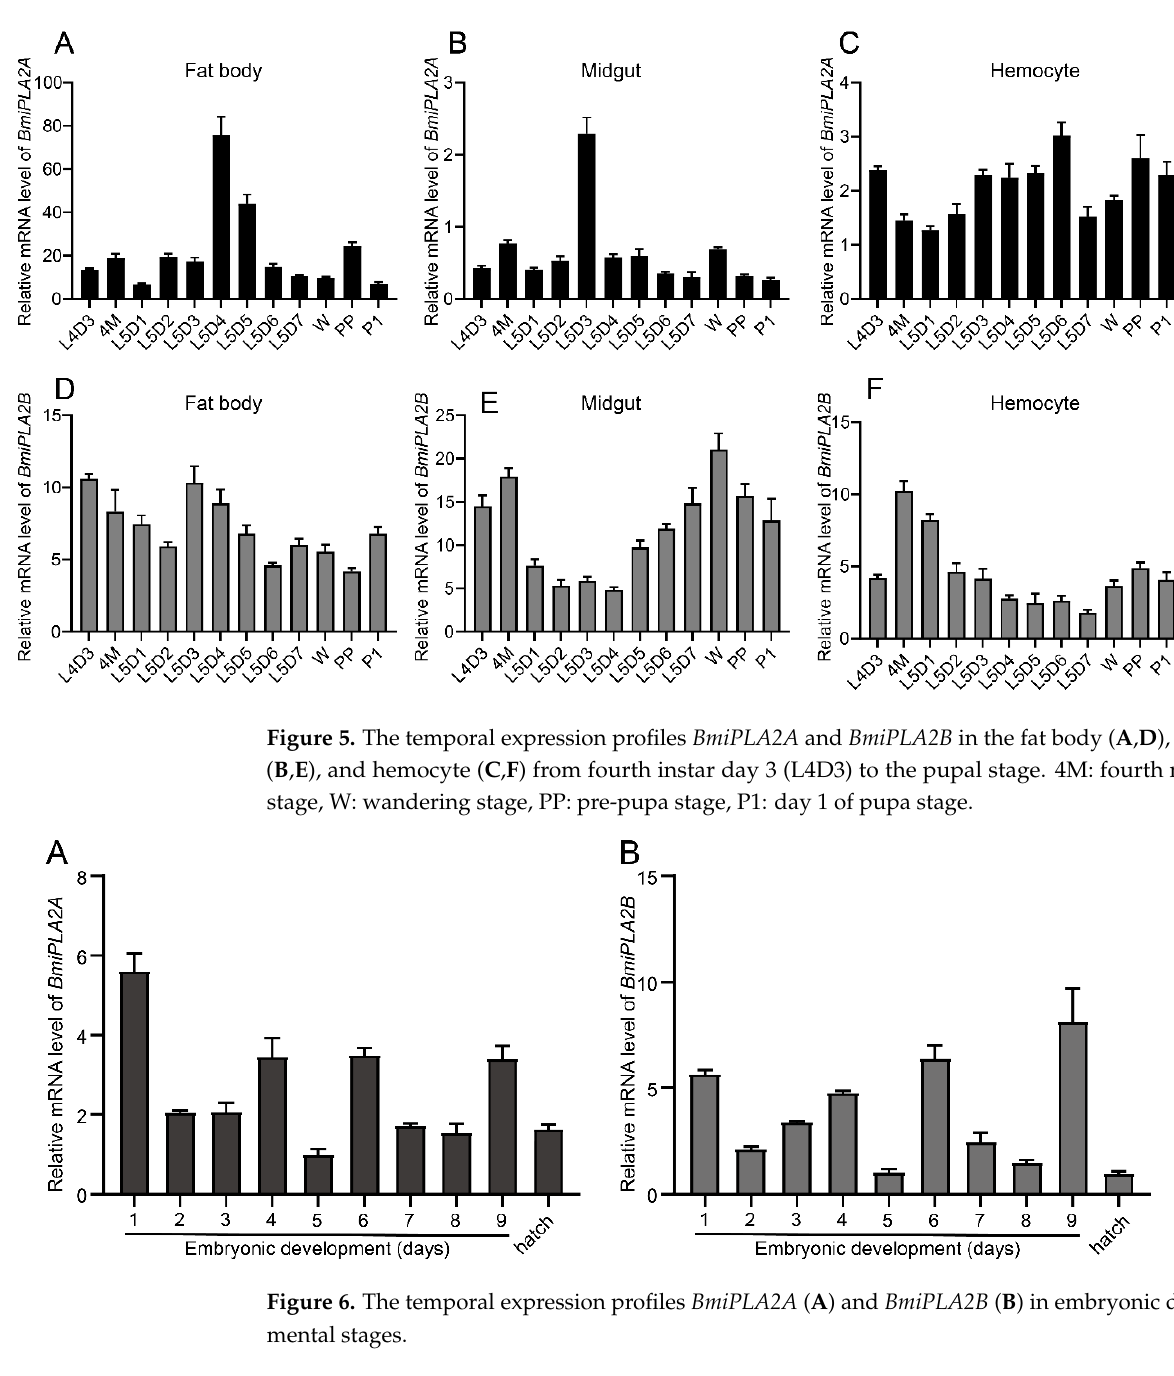
Figure 6. The temporal expression profiles BmiPLA2A ( A ) and BmiPLA2B ( B ) in embryonic devel- opmental stages.